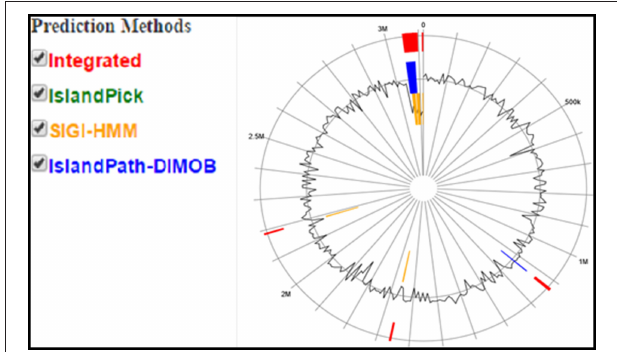
FIGURE 6 | Circular plot of Enterococcus mundtii QAUEM2808 genome islands Color scheme used in IslandViewer such as green for IslandPick, orange for SIGI-HMM, red for integrated prediction methods, http://www. pathogenomics.sfu.ca/islandviewer/results/16275/?token= rhXpqAaWROfmhio87Io6sl.